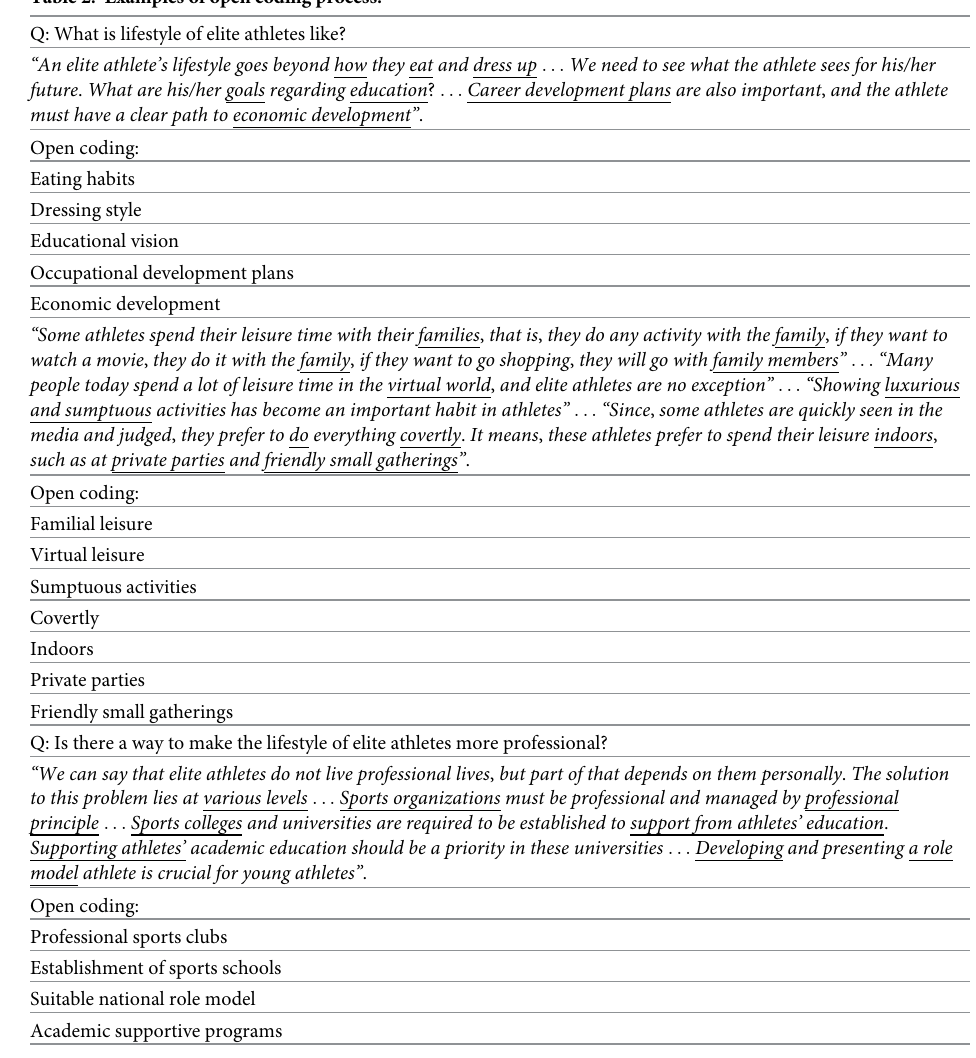
Table 2. Examples of open coding